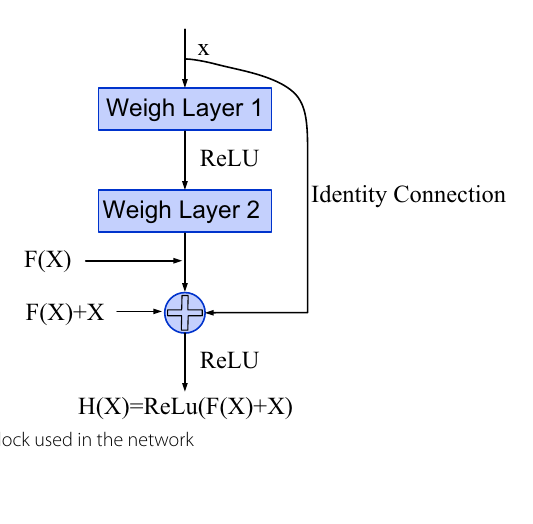
Fig. 2 The residual block used in the network